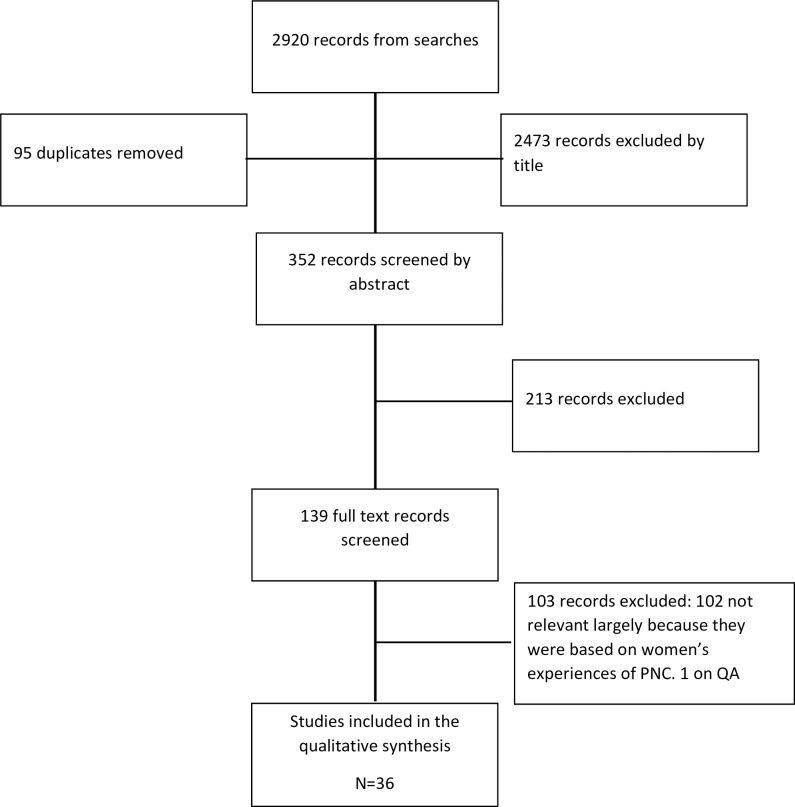
PRISMA flowchart.